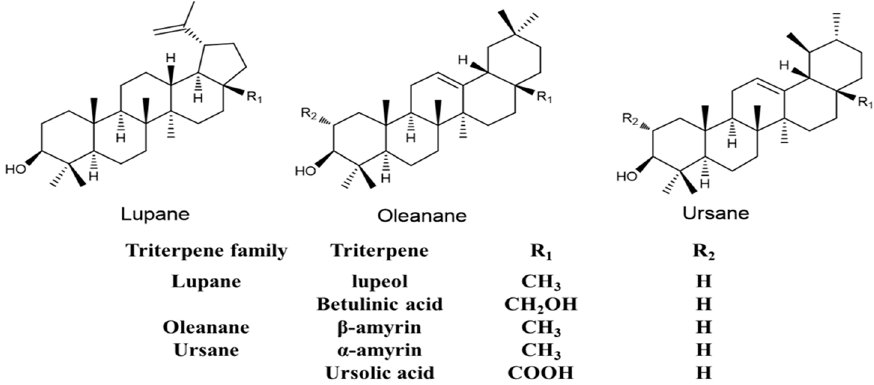
Figure 1. The triterpenes found in the active fraction of Souroubea sympetala .